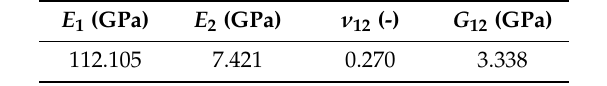
Table 2. Mechanical properties of carbon/epoxy laminate.